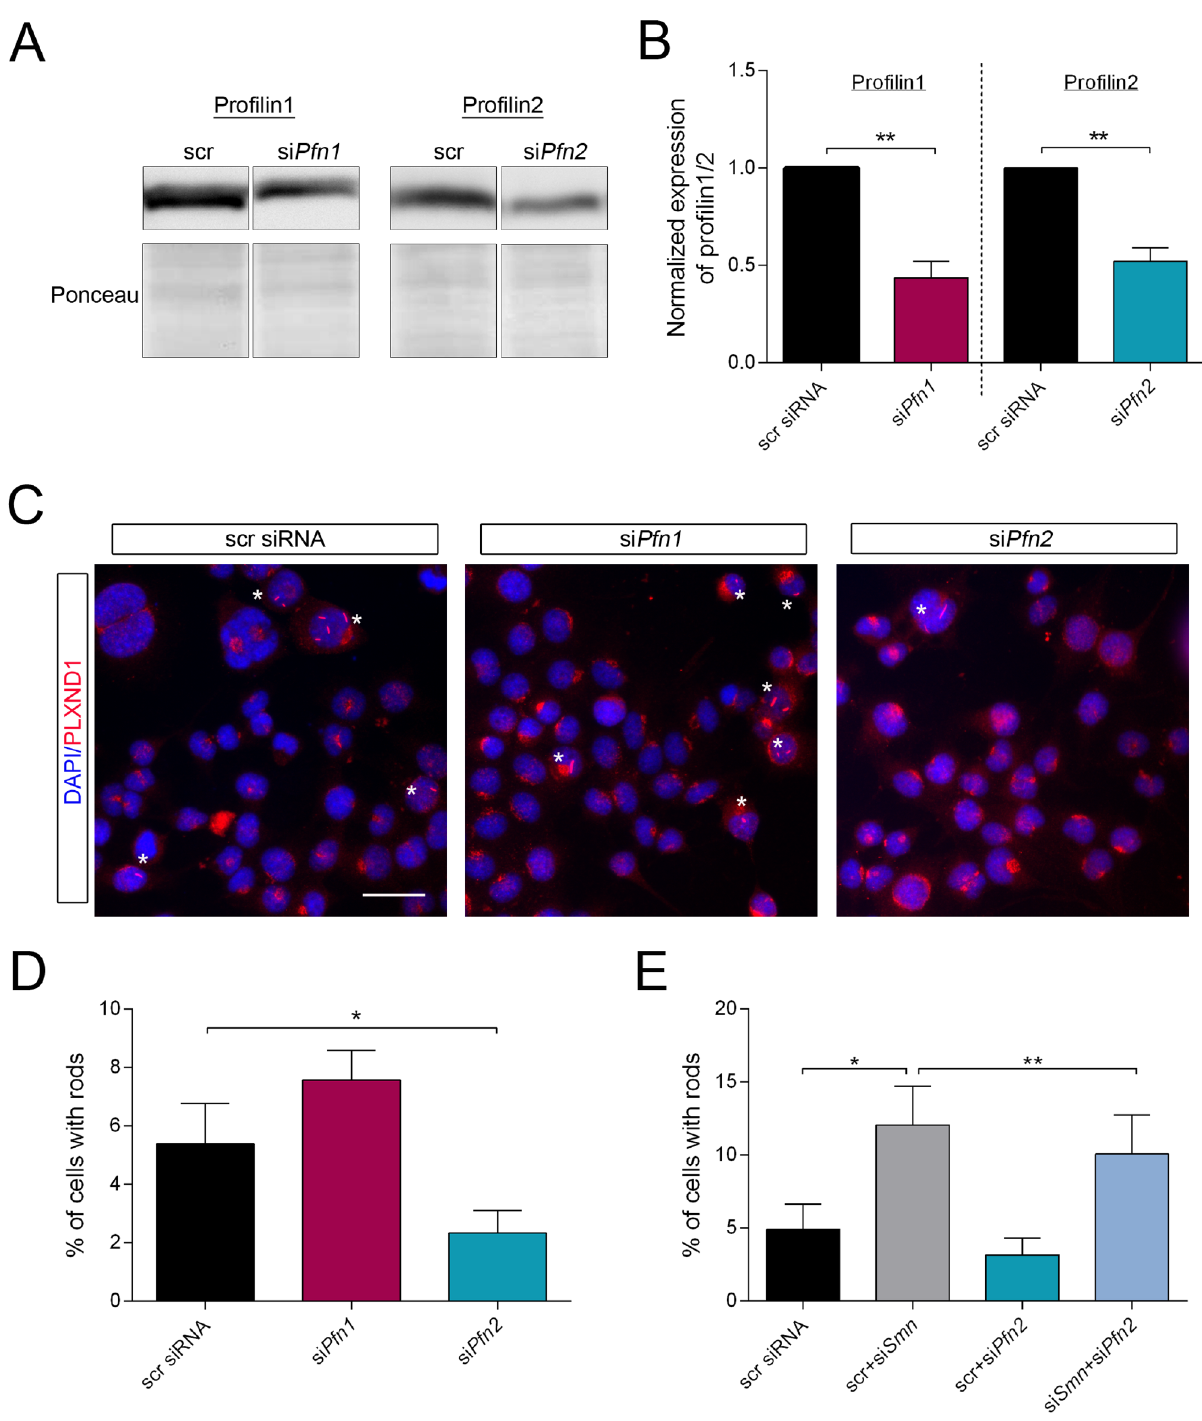
Figure 2. Profilin2 but not profilin1 is involved in actin rod formation. ( A ) Representative Western blots of cells treated with si Pfn1 or si Pfn2 . Ponceau was used as loading control. ( B ) Quantification of PFN1 and PFN2 signal normalized to total protein (mean ± SEM, n = 3, unpaired two-tailed t-test, **p < 0.01). ( C ) Immunofluorescence detection of actin rods by PLXND1 antibody in NSC34 cells treated with scr siRNA, si Pfn1 or si Pfn2 . Cells with actin rods are labeled with an asterisk. DAPI was used as nuclear counterstaining. Scale bar: 20 µm. ( D ) Quantification of actin rods in cells treated with scr siRNA, si Pfn1 or si Pfn2 (mean ± SEM, n = 5 independent biological replicates, (one-way ANOVA, Dunnett’s multiple comparison test, *p < 0.05). The following ranges represent different numbers of cells counted per condition as stated on the x-axis. Cell number counted for each replicate number was: #1: